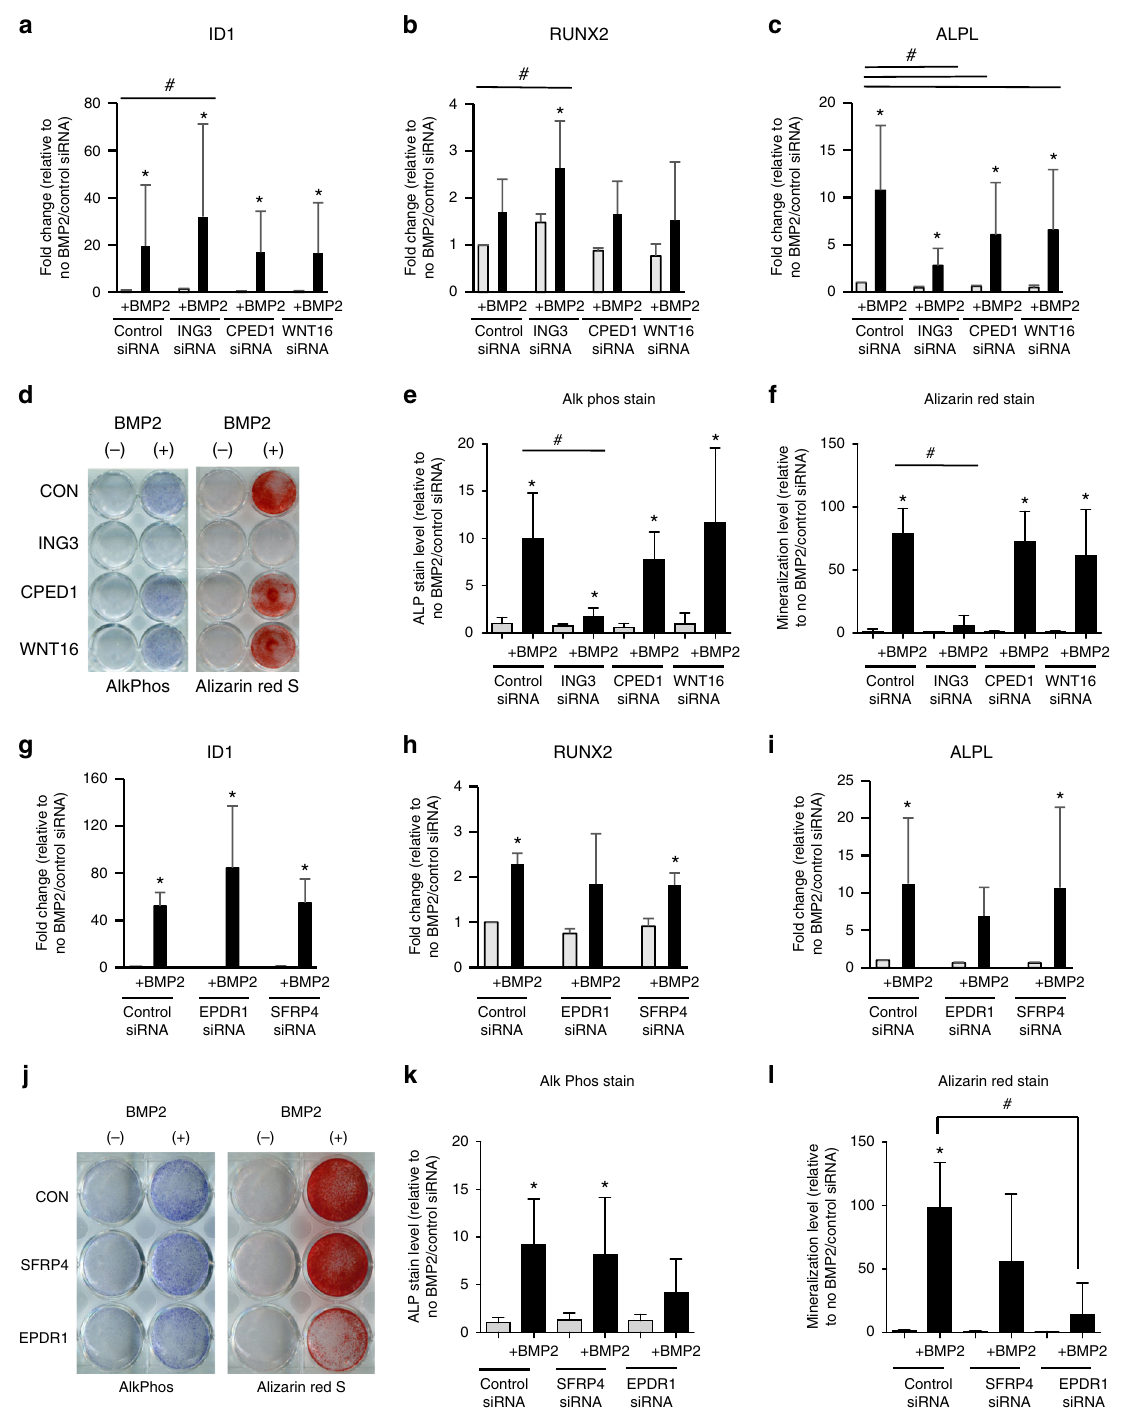
Fig. 2 Knockdowns of ING3 and EPDR1 impair osteoblast differentiation. ING3 knockdown at the GWAS implicated CPED1 locus results in a complete disruption of alkaline phosphatase induction and Alizarin red S staining, but there is no effect of CPED1 and WNT16 knockdown. Similarly, EPDR1 disruption at STARD3NL results in a reduction in alkaline phosphatase expression and activity and alizarin red S staining, but there is no effect of SFRP4 knockdown. a – c , g – i Quantitative gene expression. Gray columns = No BMP treatment; Black columns = BMP treatment. Columns = mean. Error bars = Standard deviation. n = 4 (for ING3, CPED1, and WNT16 datasets ) and n = 3 (for SFRP4 and EPDR1 datasets ) unique donor lines. * p < 0.05 comparing No treatment to BMP treatment for each siRNA. # p < 0.05 comparing control siRNA to siRNA for gene of interest (two-way homoscedastic Student ’ s t -tests). d , j Representative AlkPhos (purple) and Alizarin (red) stained plates, and e , f , k , and l quantitative image analysis of staining results repeated with four different independent hMSC donor cell lines. Source data are provided as a Source Data fi